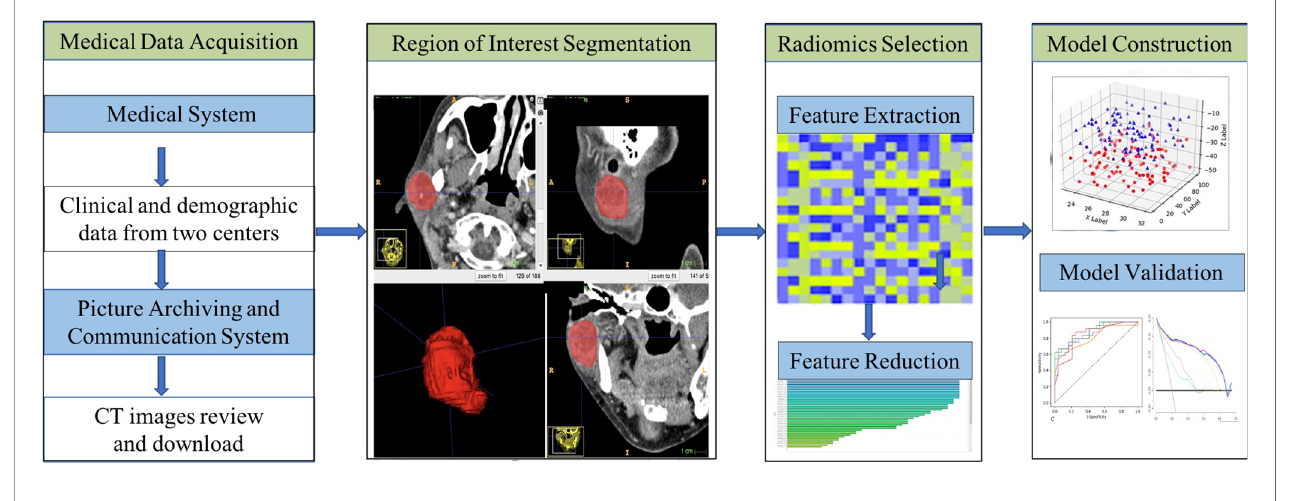
FIGURE 2 | Work fl ow of this study.